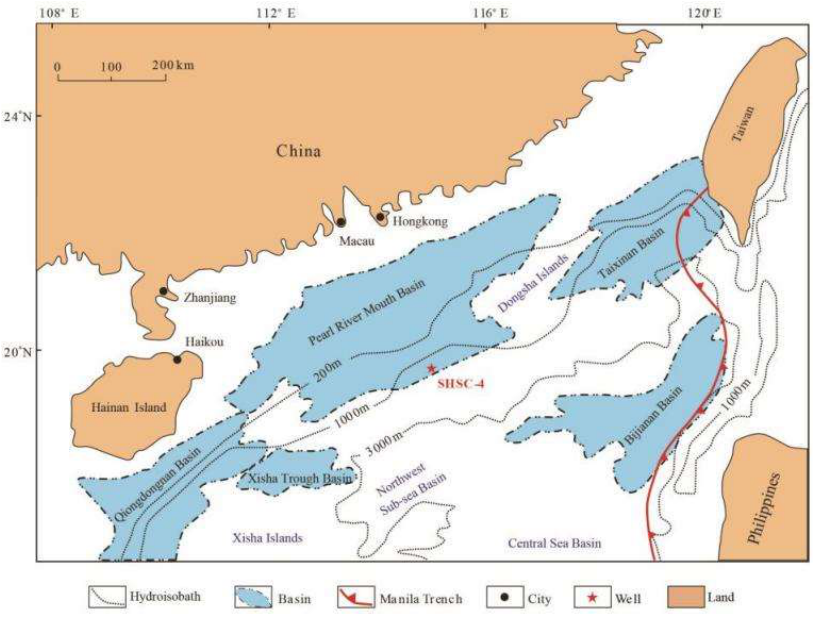
Figure 4. Structural units in the northern SCS and the location of the NGH production test area [21]. The model (Figure 5) is divided into the overburden layer (OL), NBL, MX, FGL, and underlying layer (UL) from top to bottom, corresponding to thicknesses of 15 m, 36 m, 15 m, 27 m, and 15 m, respectively. The size of the model is 500 m × 500 m × 108 m,